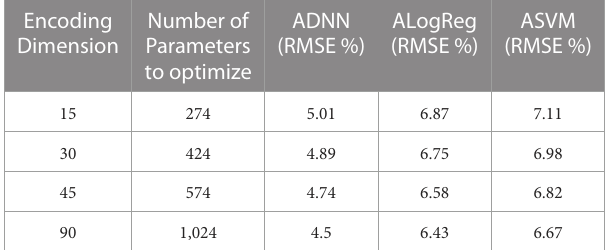
autoencoderwithlogisticregression(ALogReg),andautoencoderwithSVM (ASVM).